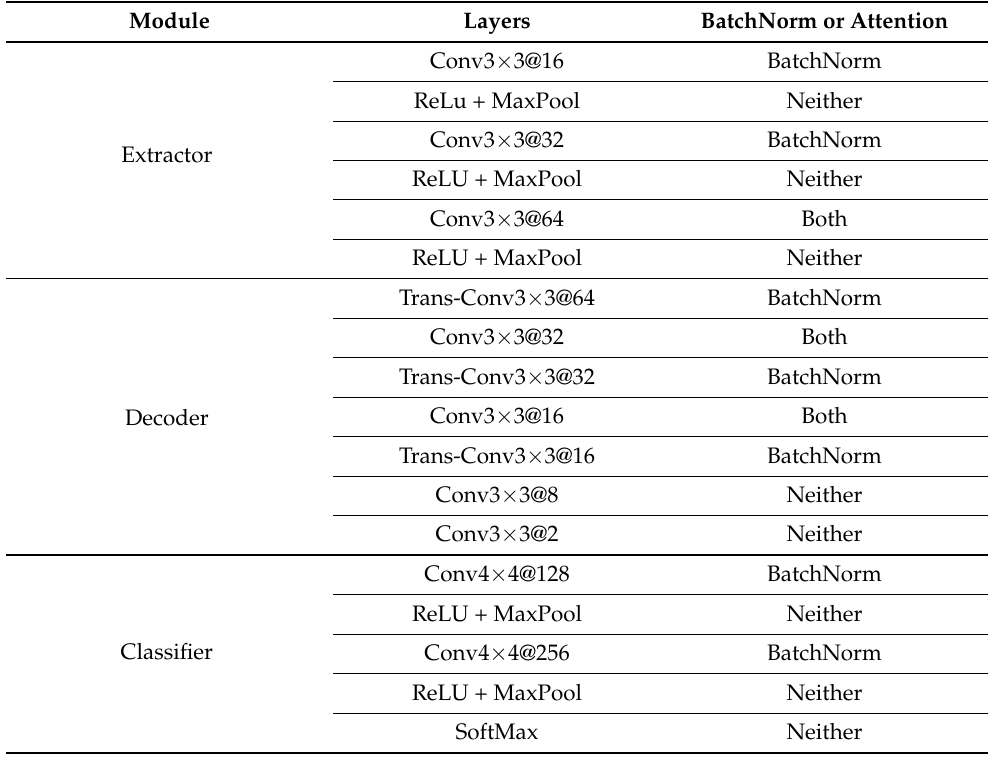
Table 2. Hyper-parameters of the proposed